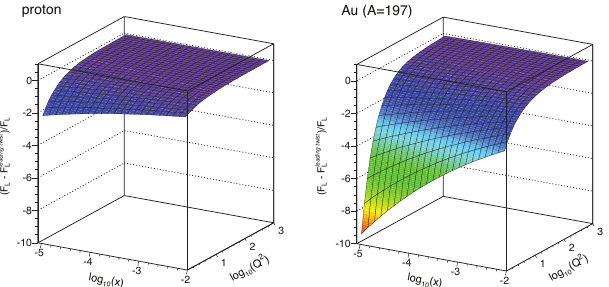
Figure 26. Relative difference between longitudinal structure function F L obtained from the sat- uration framework to that of the leading twist formalism for proton ( left ) and Gold ( right ) [190]. Figure from